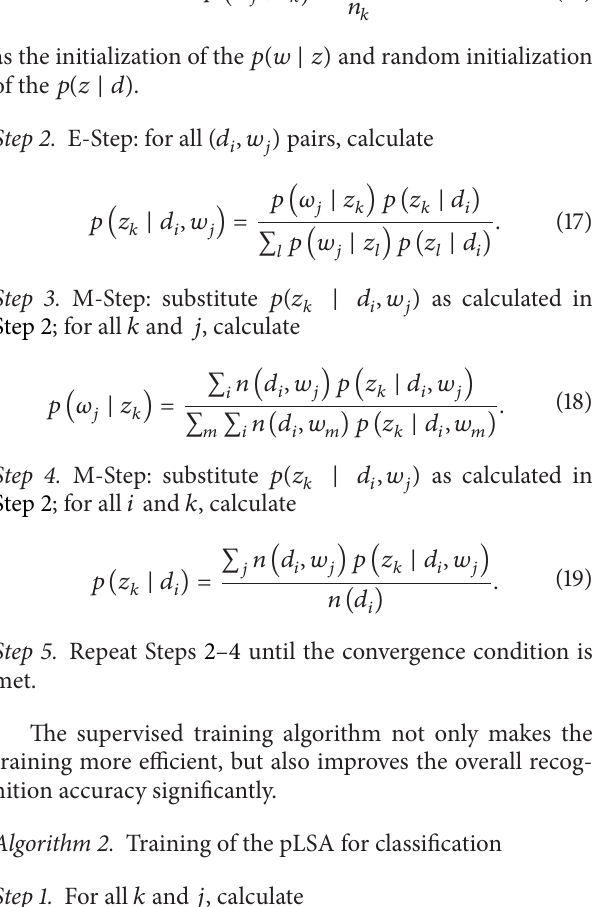
Algorithm 1. Supervised training of the pLSA.